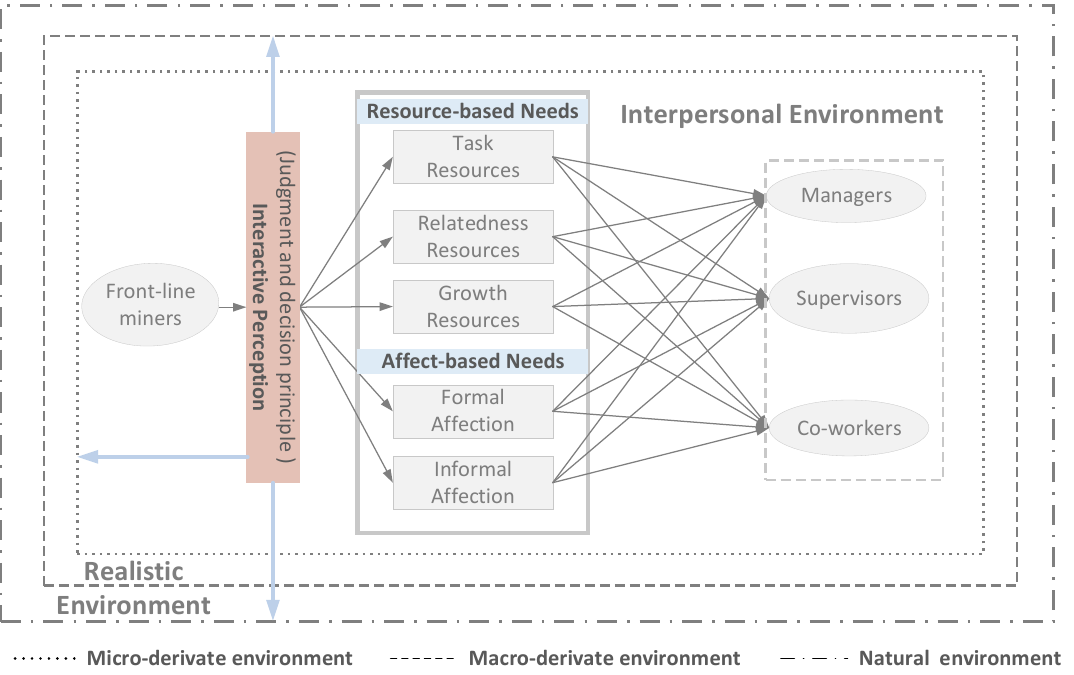
Figure 1. The structure of the psychological interaction of frontline miners in the coal mine production system.